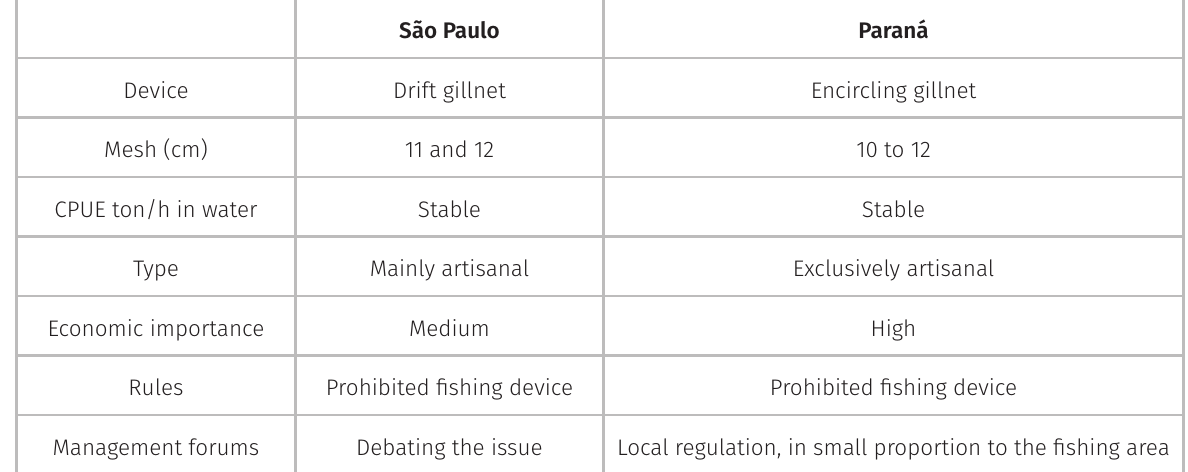
Table I. Overview of the main fishing attributes of S. brasiliensis in São Paulo and